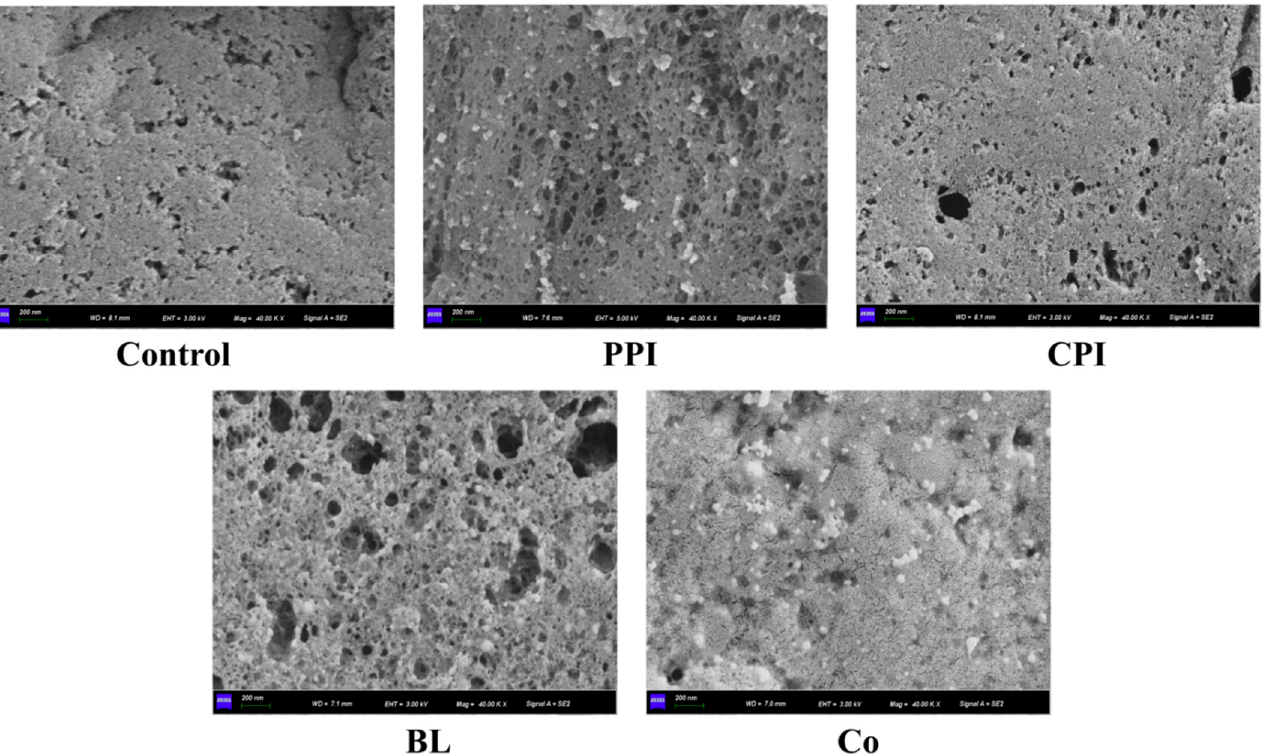
Figure 7. Effects of different protein pre-emulsified soybean oil on the microstructure of fish sausage (×40,000).